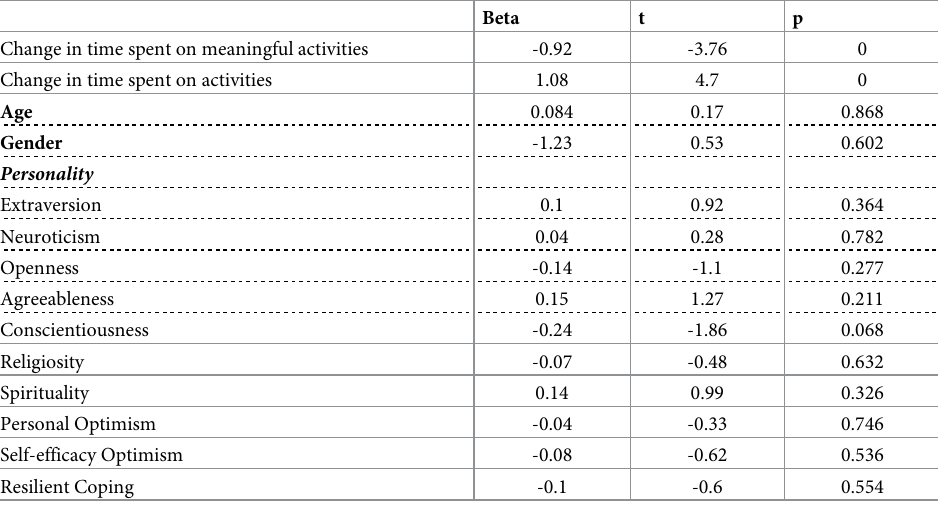
Table 2. Beta, t and p values for predictors for regression analysis